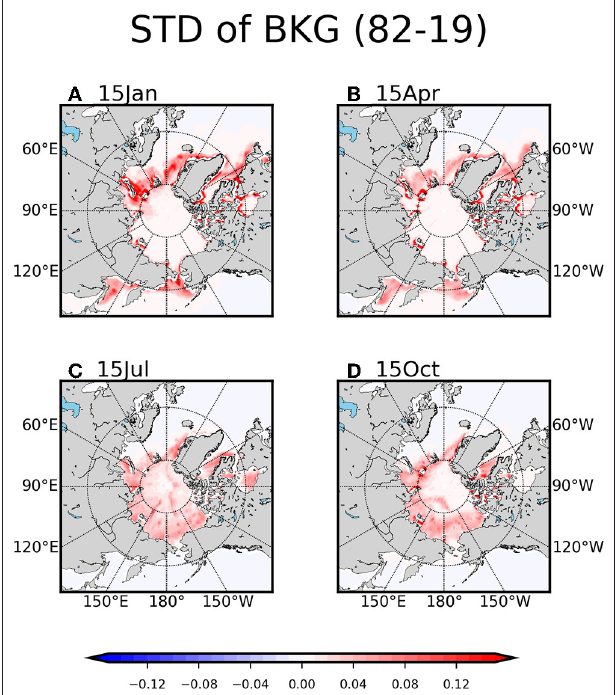
FIGURE 2 | The year-to-year standard deviation at 15th January (A) , April (B) , July (C) , and October (D) of forecast error perturbations for sea ice concentration (a fraction from 0 to 1) generated by using long-time integration during